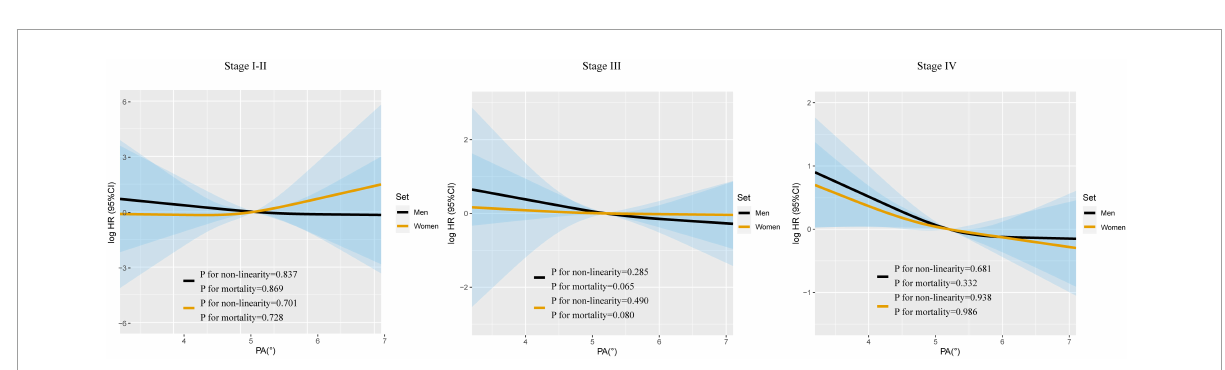
FIGURE2 The sex-specific association between PA and all-cause mortality in patients with lung cancer based on TNM stage. Model c: Adjusted for age, TNM stage, BMI, smoking, alcohol drinking, diabetes mellitus, hypertension, coronary heart disease, chemotherapy, radiotherapy, and